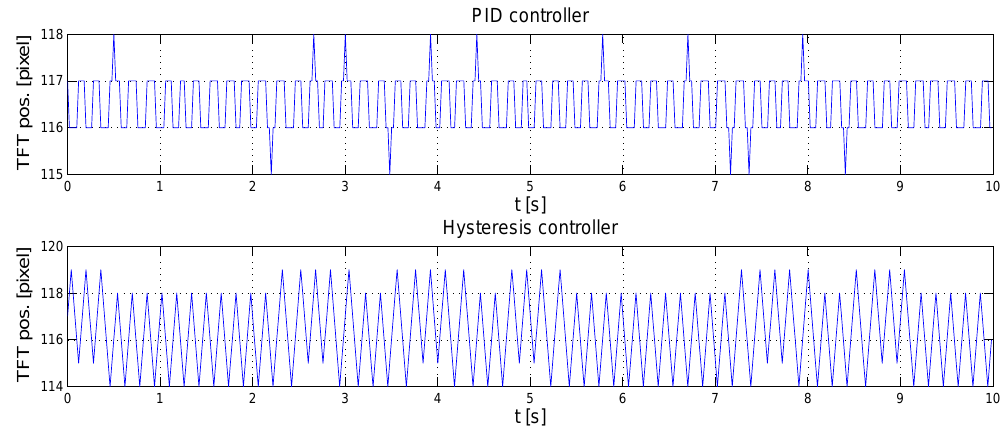
Figure 13. Comparison of hysteresis and PID controller.